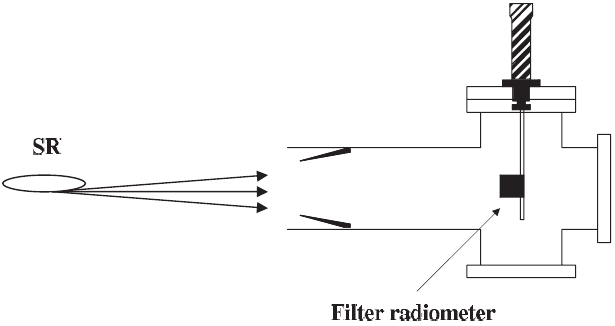
FIG. 3. Schematic diagram of the end chamber for measuring angular distribution of synchrotron